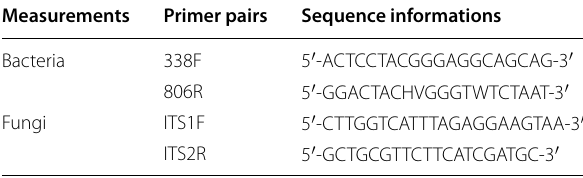
Table 1 The sequence informations of primer